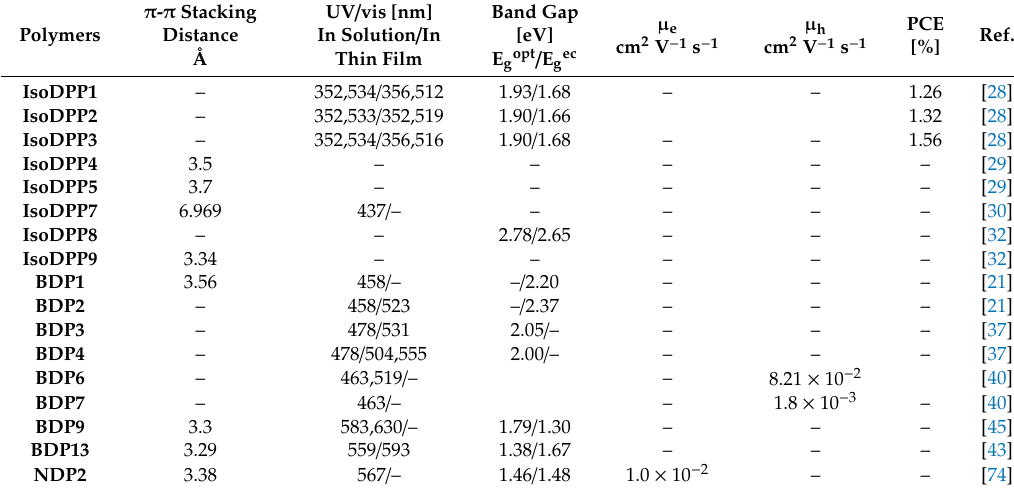
Table 1. List of properties of small molecules based on isoDPP, BDP, and NDP.